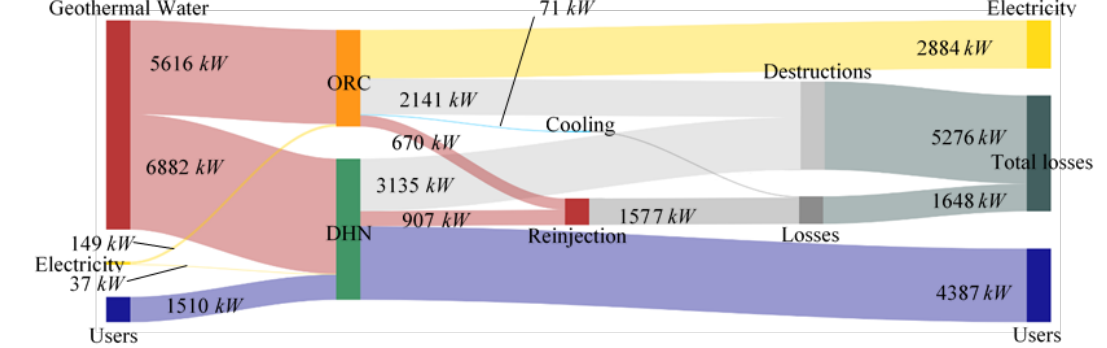
Figure 4. Exergy flow for max 𝑃𝑟𝑜𝑓𝑖𝑡 .